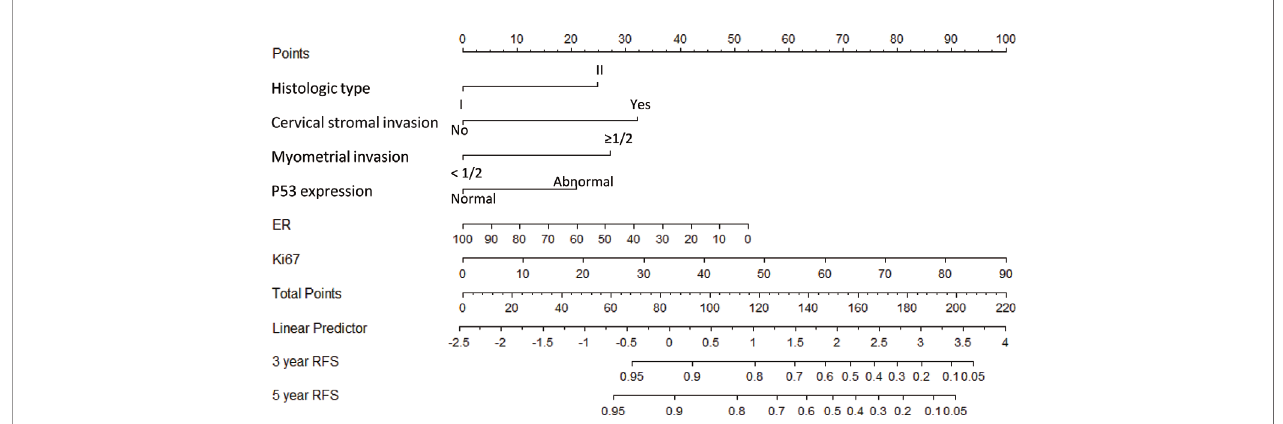
FIGURE 2 | Nomogram model for estimating the rate of recurrence free survival (3 or 5 years) for women with I – II FIGO stage endometrial cancer Description: To estimate the recurrence risk, calculate points for each variable by drawing a straight line from patient ’ s variable value from the 2nd to 6th line to the 1st line labelled ‘ Points ’ . Sum all points and draw a straight line from the 7th line to the 9th line-10th line to get the 3-, and 5-year recurrence-free survival rate.